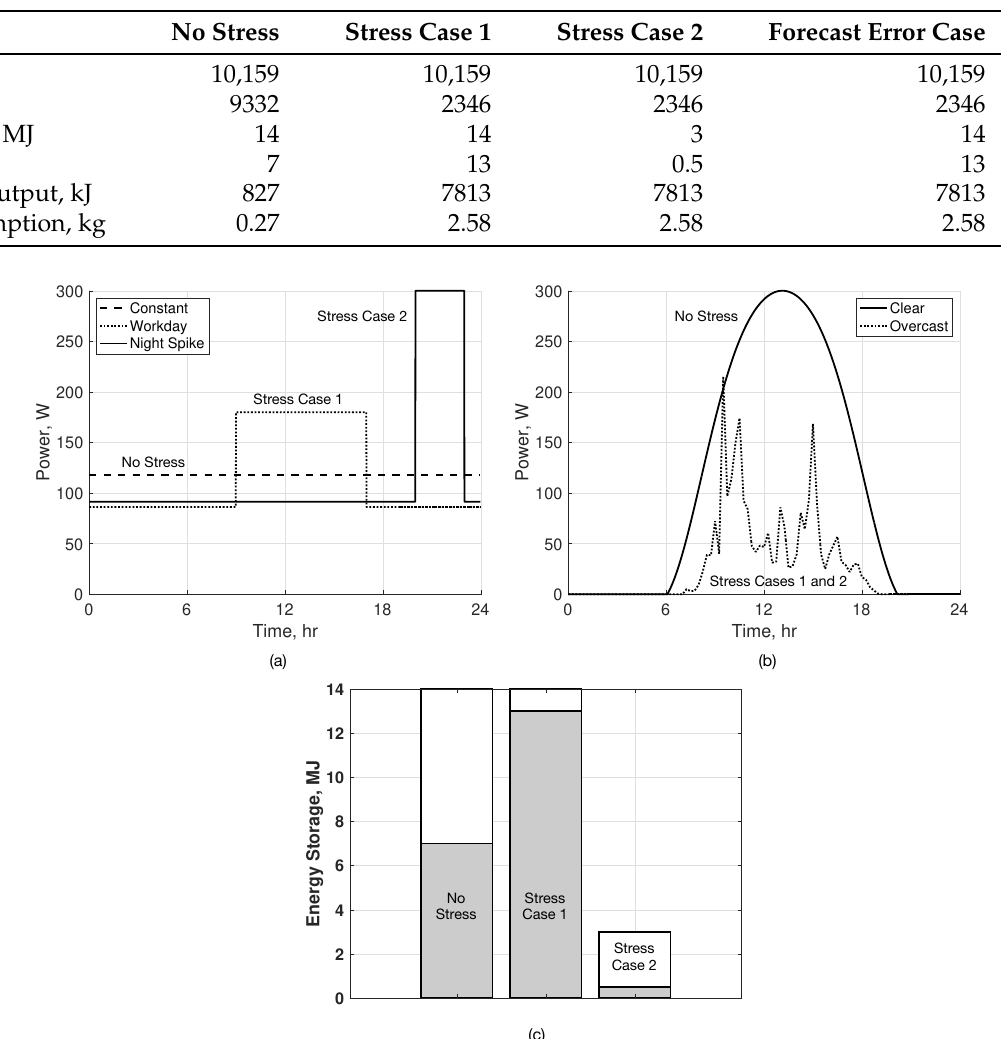
Table 1. Summary of the four cases used to evaluate the EMS strategies.